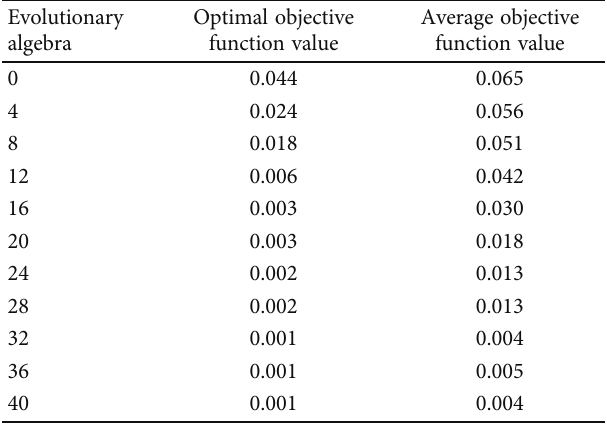
Table 5: Parameter optimization evolution